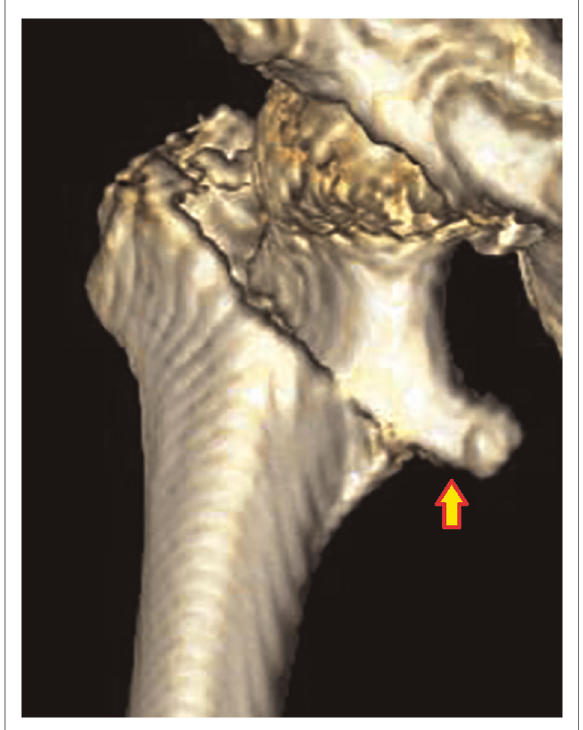
FIGURE 5 Subtype A1.3, displaced two-part fractures with lesser trochanter bisected. The arrow indicates the upper part of the lesser trochanter with the proximal head – neck fragment.